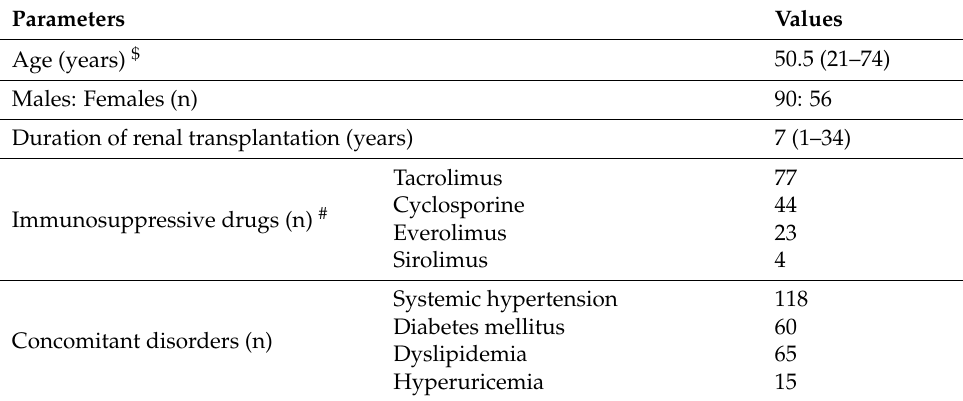
Table 1. Demographics of study participants (N = 146).